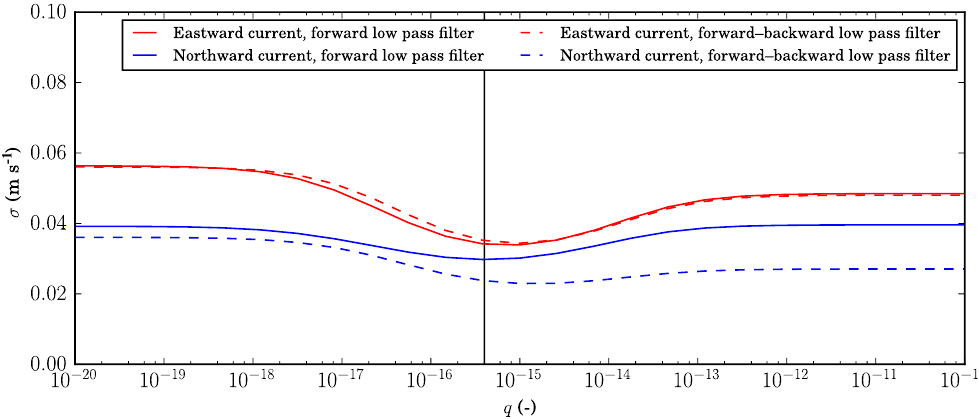
Figure 4. Standard deviations of the errors of the eastward (blue) and northward (red) current components, as a function of the variance parameter q (process noise). The solid lines were obtained using a forward low pass filter to remove the residual current (near-real-time mode), whereas the dashed lines were obtained using a forward–backward low pass filter (delayed mode). The black line indicates q = 4 × 10 − 16 , which is the optimal value taking into account eastward and northward currents as well as near-real-time and delayed mode scenarios.